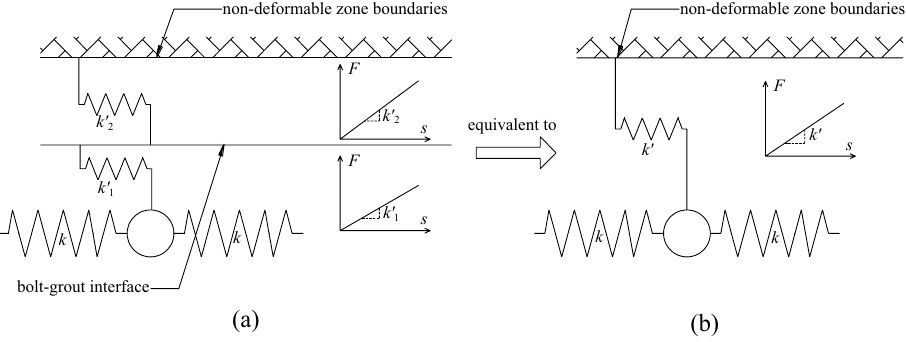
Figure 7. Evolution of the spring model. ( a ) When both interfaces are mechanical interlock; ( b ) The spring model.